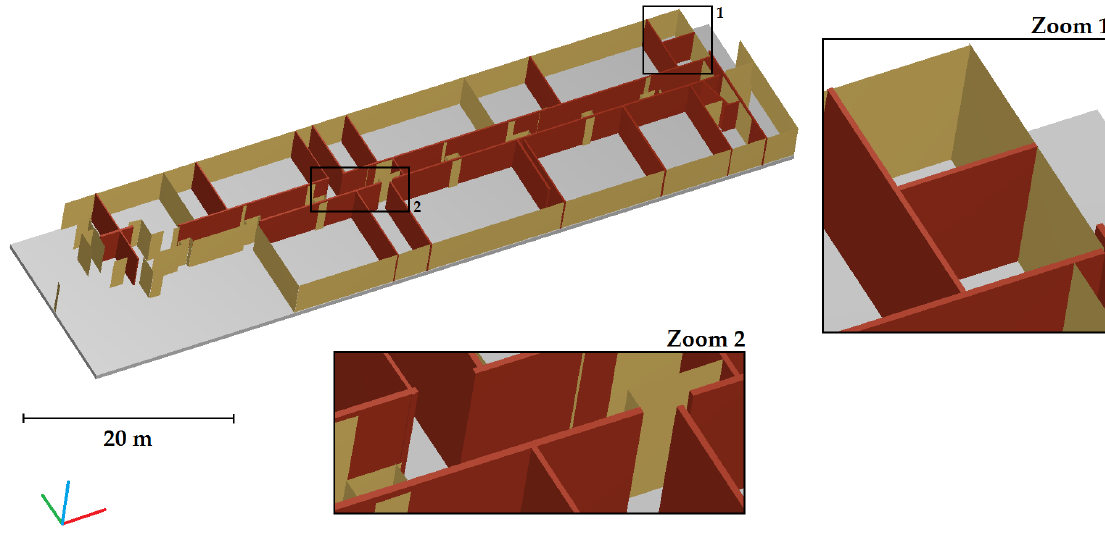
Figure 8. Reconstruction of slabs and walls—1st floor of the INSA